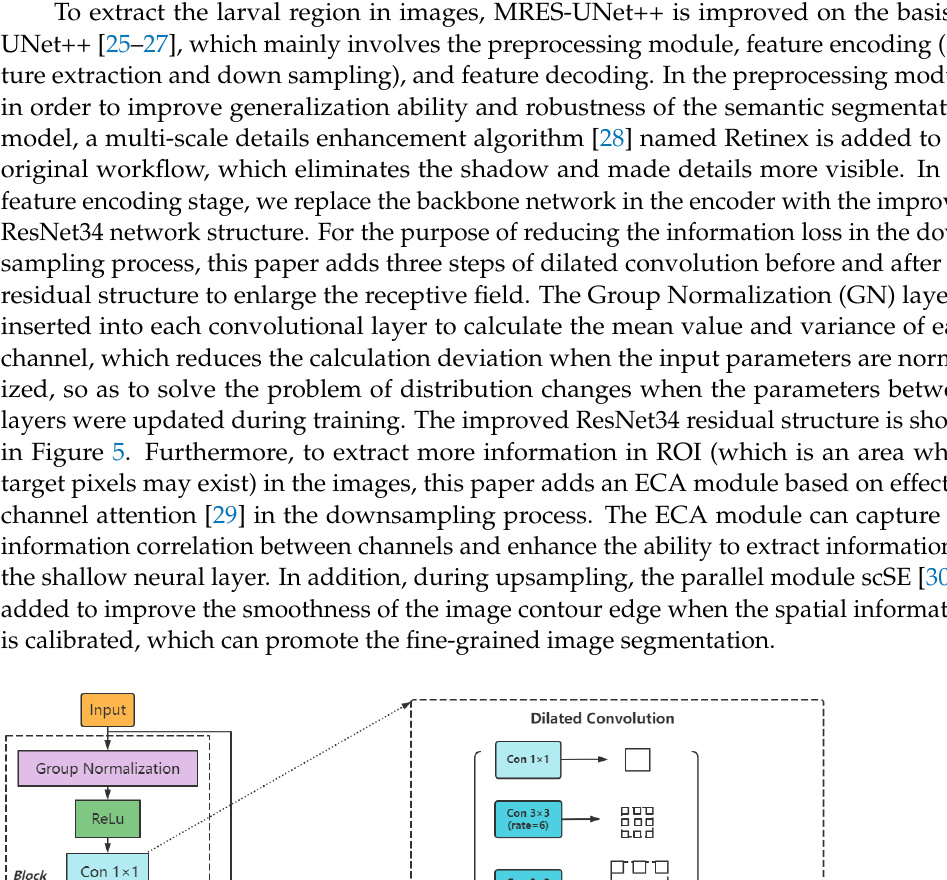
Figure 4. The architecture of MRES-UNet++ for segmenting the FAW larva.